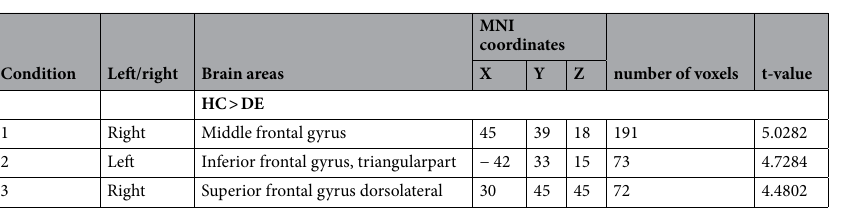
Table 2. Brain areas with significantly different ReHo values between groups. The statistical threshold was set at voxel level with P < 0.05 for multiple comparisons using Gaussian random field theory voxels with P < 0.001 and cluster size > 40 voxels, alphaSim corrected. ReHo regional homogeneity, DE dry eye, HC healthy control, MNI Montreal neurological institute.